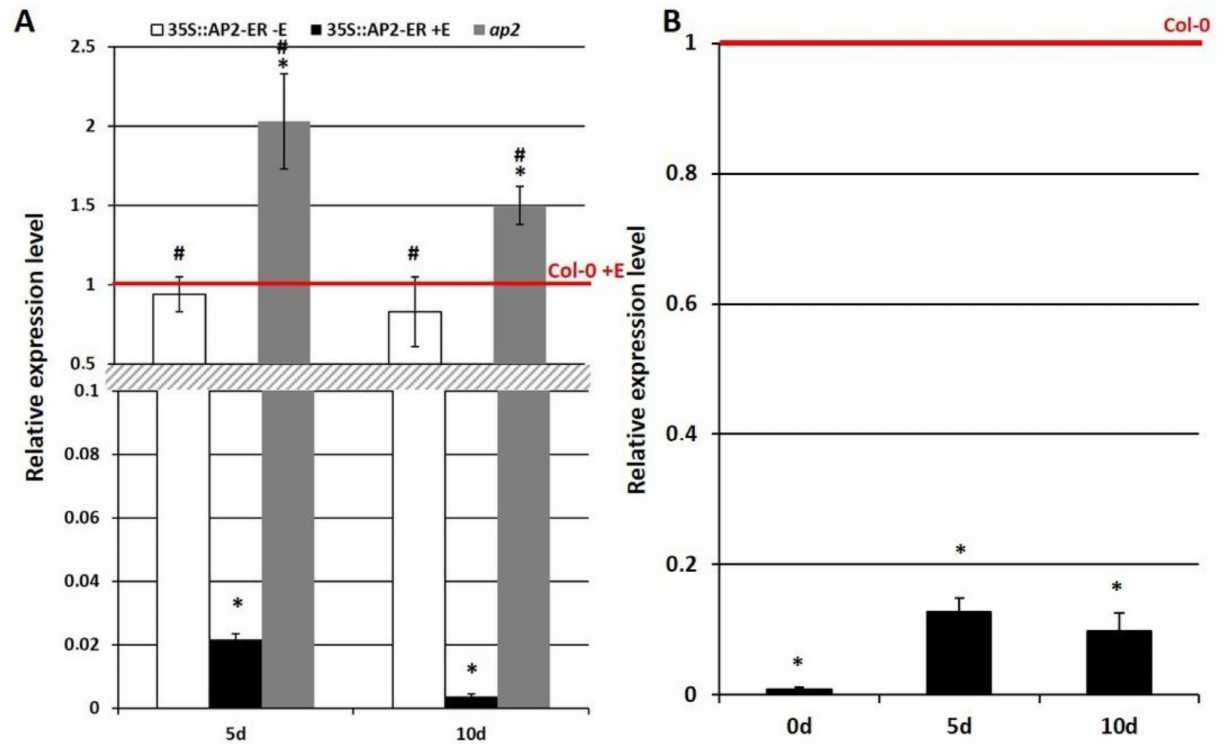
Figure 5. Expression analysis of WUS in the SE culture in AP2 -induced overexpression line and ap2 mutant ( A ) and 35S::MIM172 line with a disrupted miR172 function ( B ). AP2 overexpression was induced with β -estradiol (+E). The relative transcript level was normalized to an internal control ( At4g27090 ) and calibrated to the WT (Col-0) culture of the same age (0d, 5d and 10d). * values significantly different from the Col-0 culture of the same age ( p < 0.05; n = 3 ± SD); #—values significantly different from the 35S:: AP2 -ER +E culture of the same age ( p < 0.05; n = 3 ±